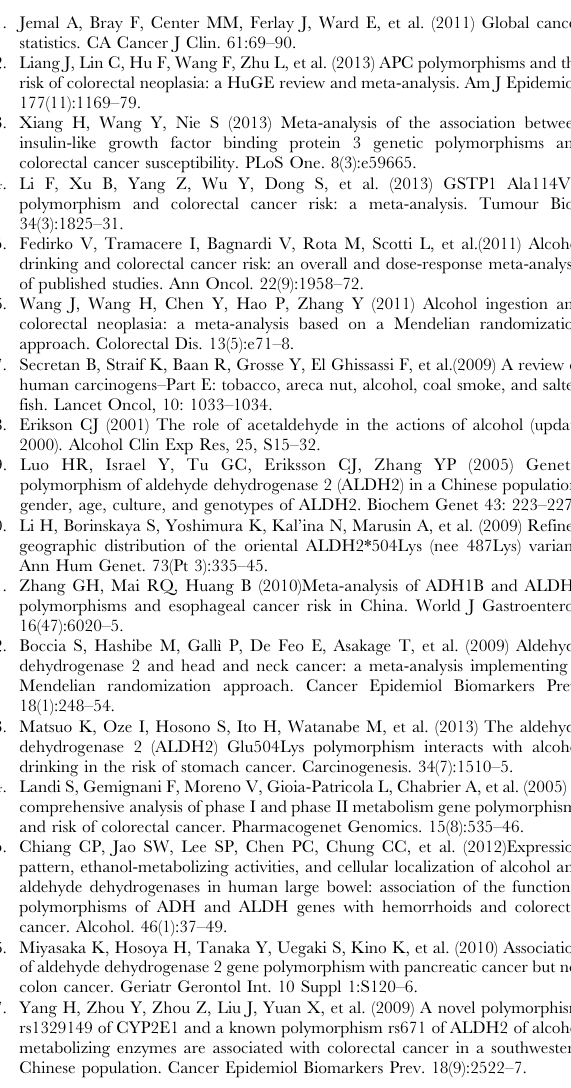
multiple testing using BH-FDR